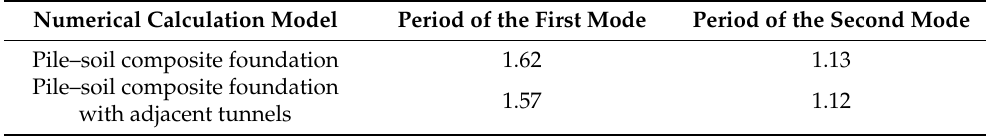
Table 3. Period of the main